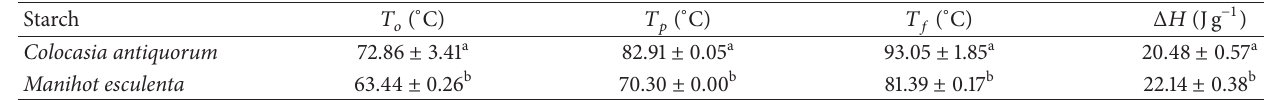
a - b Different superscript letters in the same column indicate statistical difference ( 𝑃 < 0.05